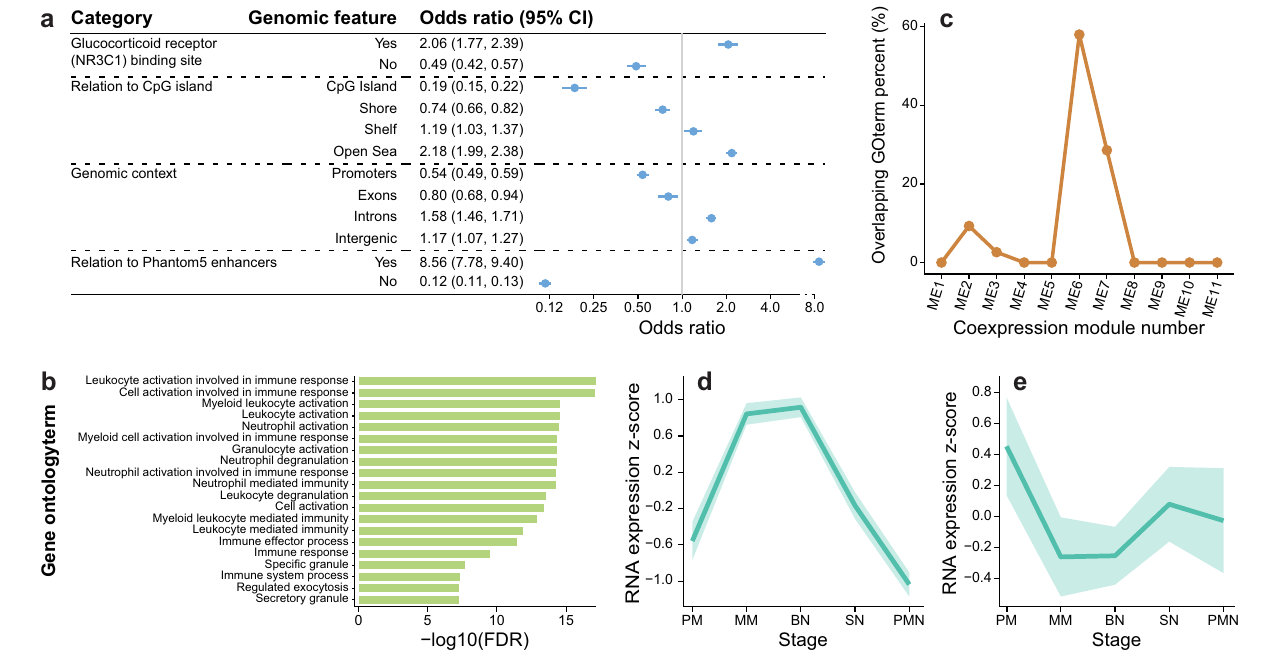
Fig. 3 | Functional features and gene ontology analyses of genes containing neutrophil-speci fi c DEX loci. a Genomic context enrichment of neutrophil- speci fi c CpGs ( n =2621) with all tested CpGs ( n =830,277) as background. b Enriched GO terms associated with 1360 genes displaying differentially methy- lated DEX loci and interaction with neutrophil proportions. c Percent of GO terms in the myeloid expression (ME) modules overlapping with the GO terms enriched for 1360 neutrophil-speci fi c loci associated genes. ME6 displayed the highest overlapping percent (58%) with 29 out of 50 overlapping with neutrophil-speci fi c GOterms. d Plotofmaximalexpressionof21overlappingdifferentiallymethylated